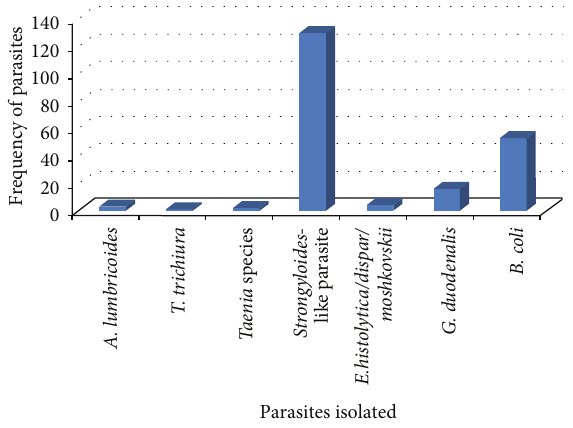
Figure 1: Percentage of parasite species isolated from populations of B. germanica in Jimma Town, southwestern Ethiopia,